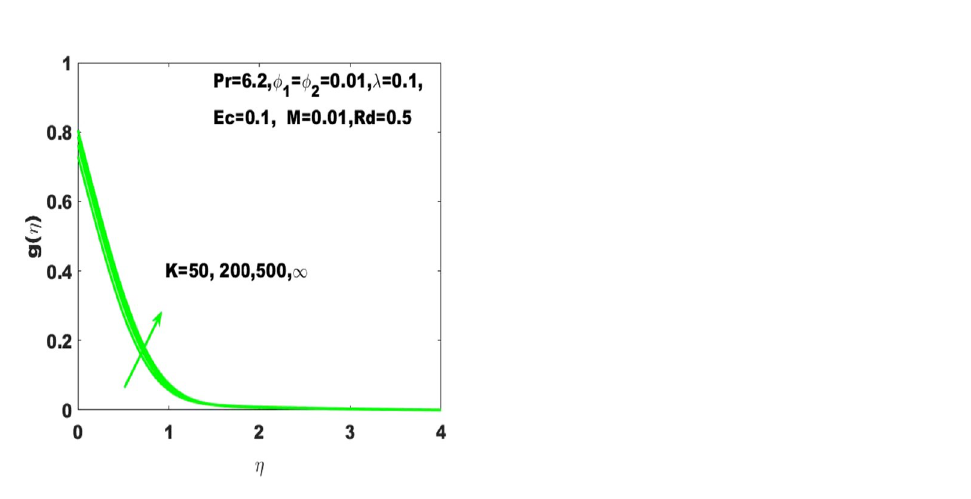
Figure 9. g ( η ) for diverse values of K.